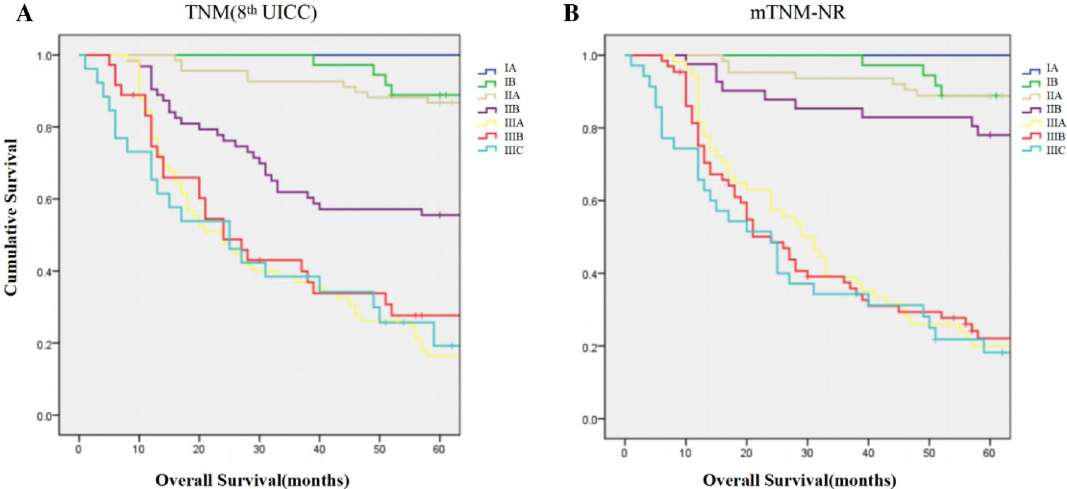
Figure 2. Kaplan–Meier curves. ( a ) Kaplan–Meier curves according to the TNM (8th UICC/AJCC) classification system. ( b ) Kaplan–Meier curves according to the mTNM-NR classification system. UICC union of international cancer control, AJCC American joint committee on cancer, NR lymph node metastatic ratio, mTNM-NR modified TNM stage using NR. NR